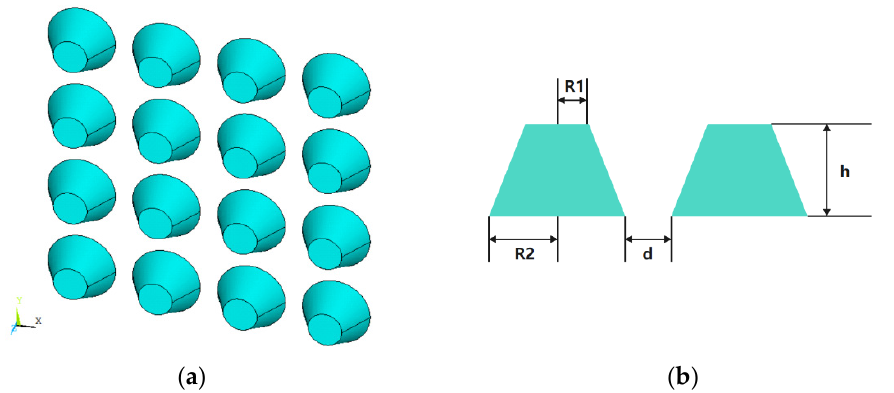
Figure 12. Structure of the gold-nano-truncated cone array. ( a ) 3D view; ( b ) dimensions of the nanosphere array, where d = 10 nm, R2 = 20 nm, R1 = 10 nm, h = 20 nm.